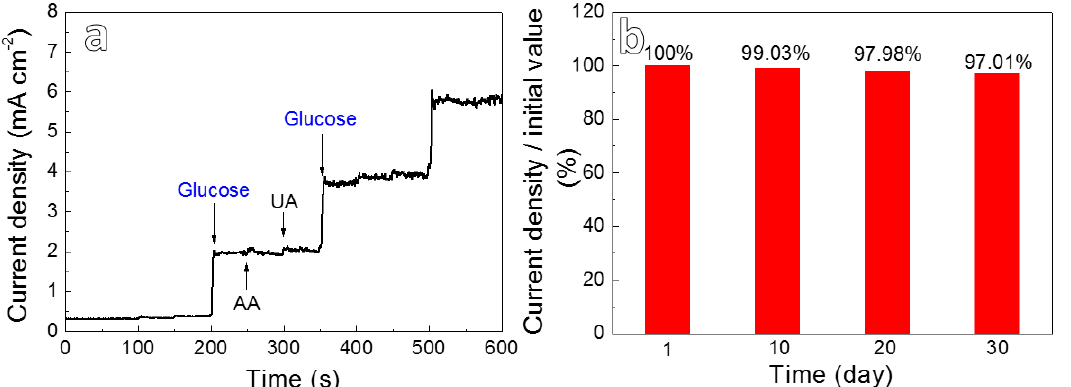
Figure 6. ( a ) Anti-interference ability measurement of Cu x O/Ag 2 O-10 at an applied potential of 0.5 V; ( b ) the stability of the Cu x O/Ag 2 O-10 electrode over a period of 30 days.